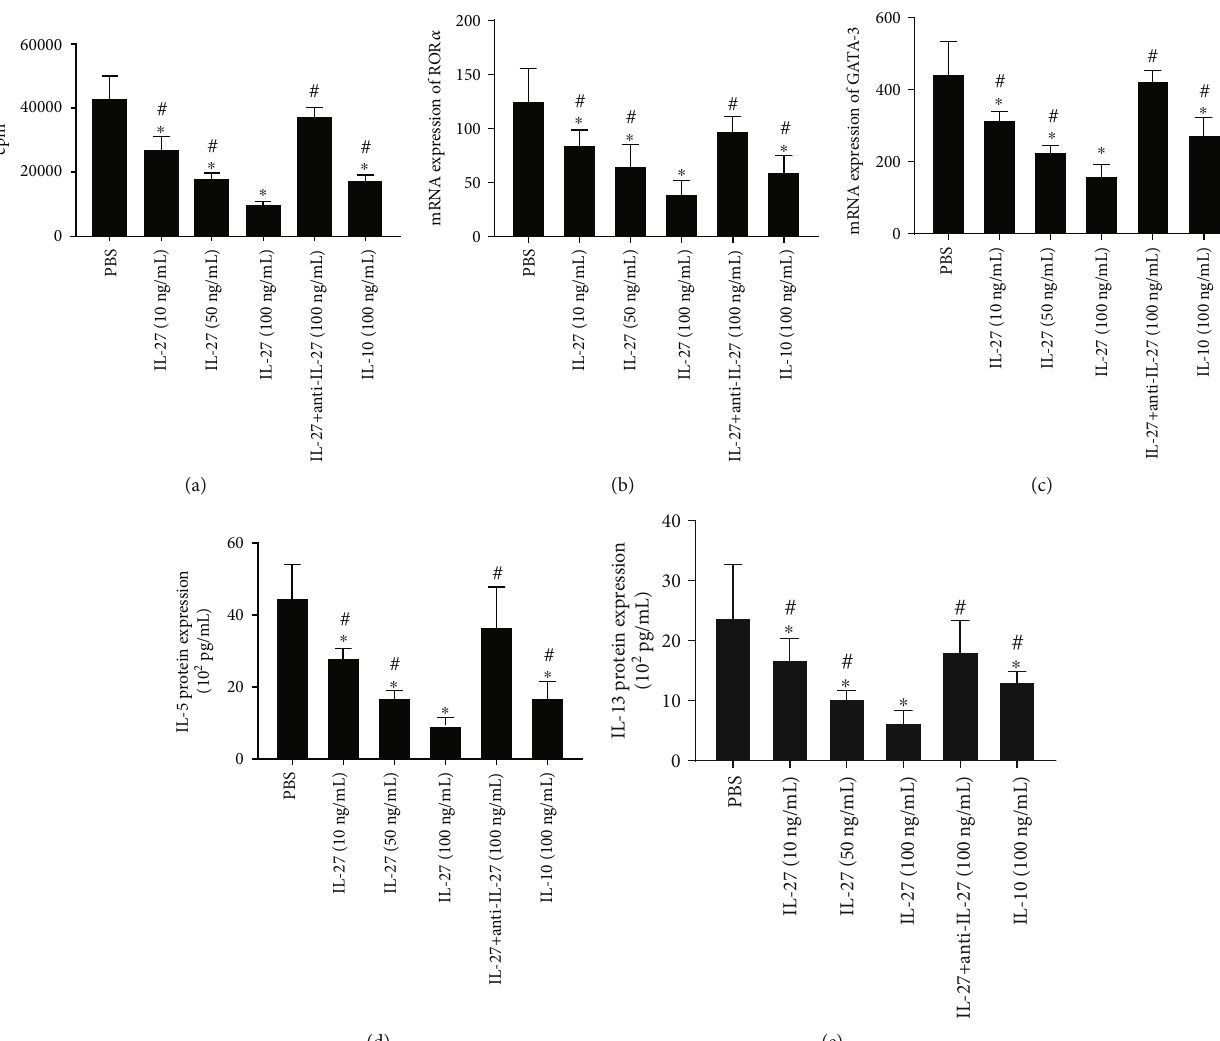
Figure 4: IL-27 inhibited ILC2 cell proliferation and cytokine expression. (a) Proliferation of ILC2 was assessed by tritiated thymidine incorporation under IL-27 stimulation. (b, c) The mRNA expression of GATA-3 and ROR α by ILC2 detected by PCR. (d, e) Type II cytokine protein expression by ILCA2 measured by ELISA. Three independent tests were performed for every experiment. ∗ Compared with PBS, P < 0 : 05 . # Compared with IL-27 (100ng/mL), P < 0 : 05 . cpm: counts per minute; ROR α : Retinoic Acid-Related Orphan Receptors α ; GATA-3: GATA binding protein-3; ILC2: group II innate lymphoid